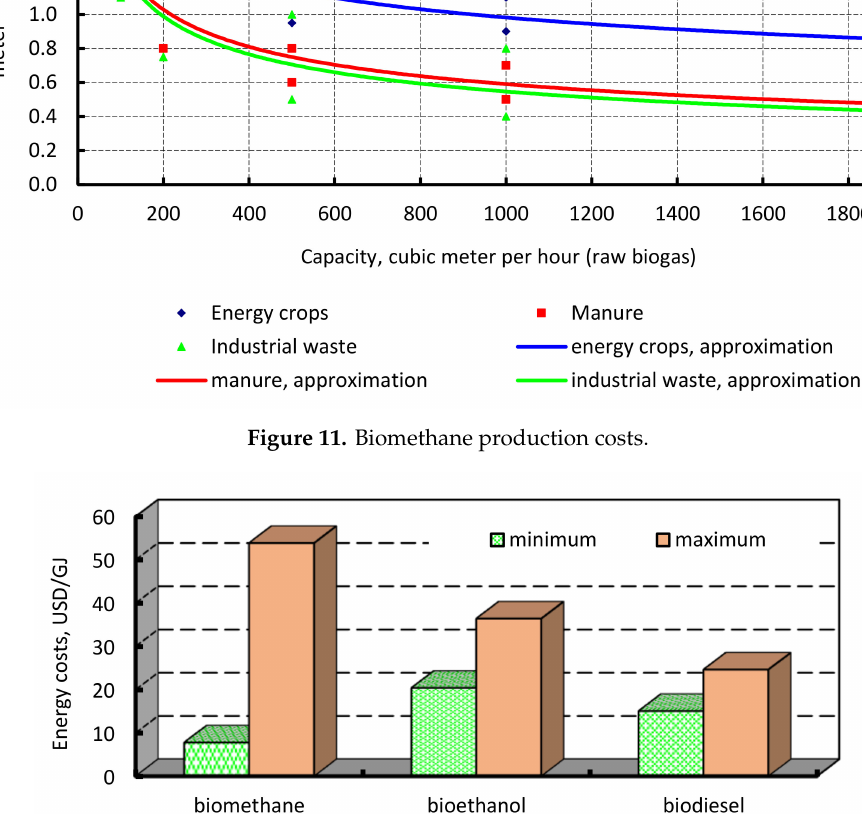
Figure 12. Cost of biomethane production compared to